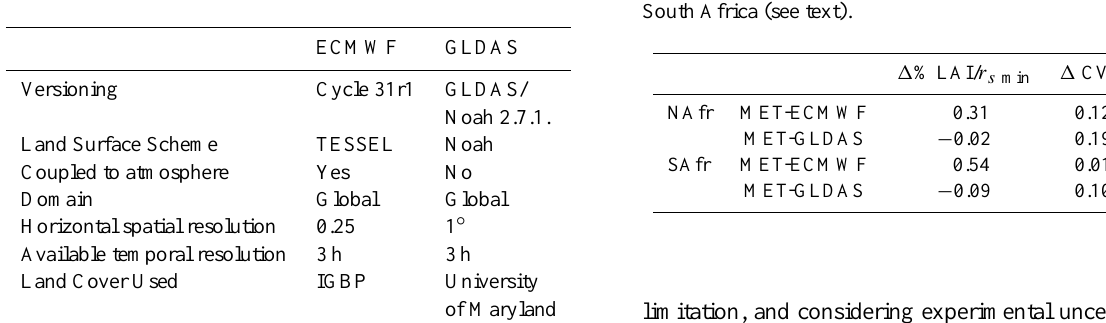
Table 4. Summary of models characteristics and output used for inter-comparison.